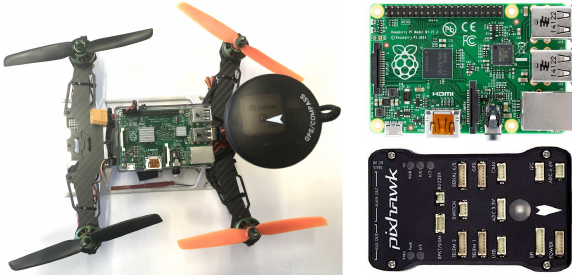
Figure 1: (left) a drone prototype (used in actual flight operations), (right, top) the Raspberry Pi 2 and (right, bottom) the pixhawk flight module /